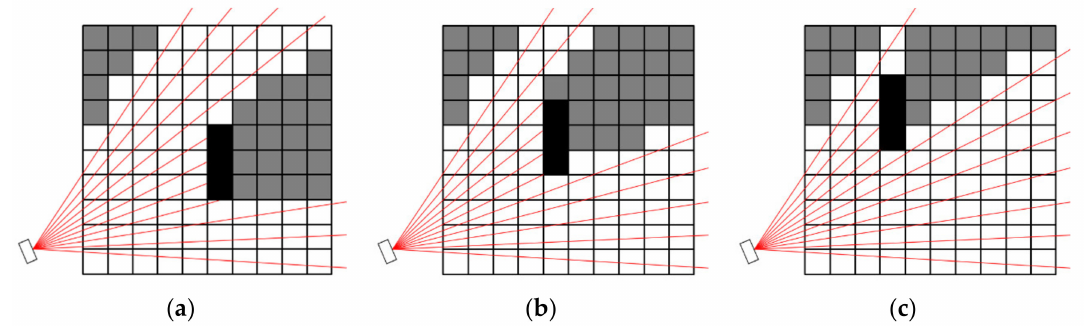
Figure 7. Camera coverage of a voxel map with a moving obstacle (black voxels) during three time moments; ( a ) t 1 ; ( b ) t 2 ; ( c ) t 3